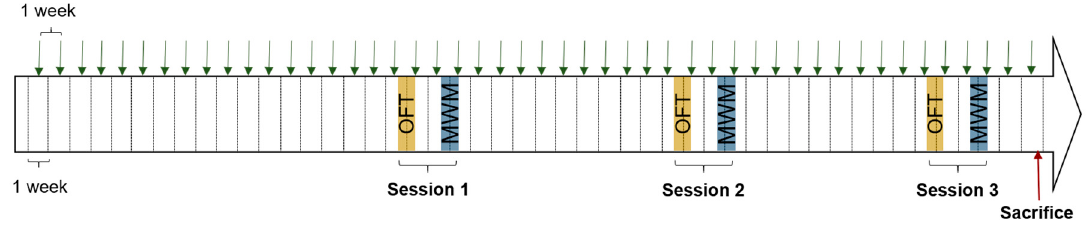
Figure 1. Schematic representation of the study design. Green arrows: fipronil or vehicle administration; OFT: open-field test; MWM: Morris water maze test.